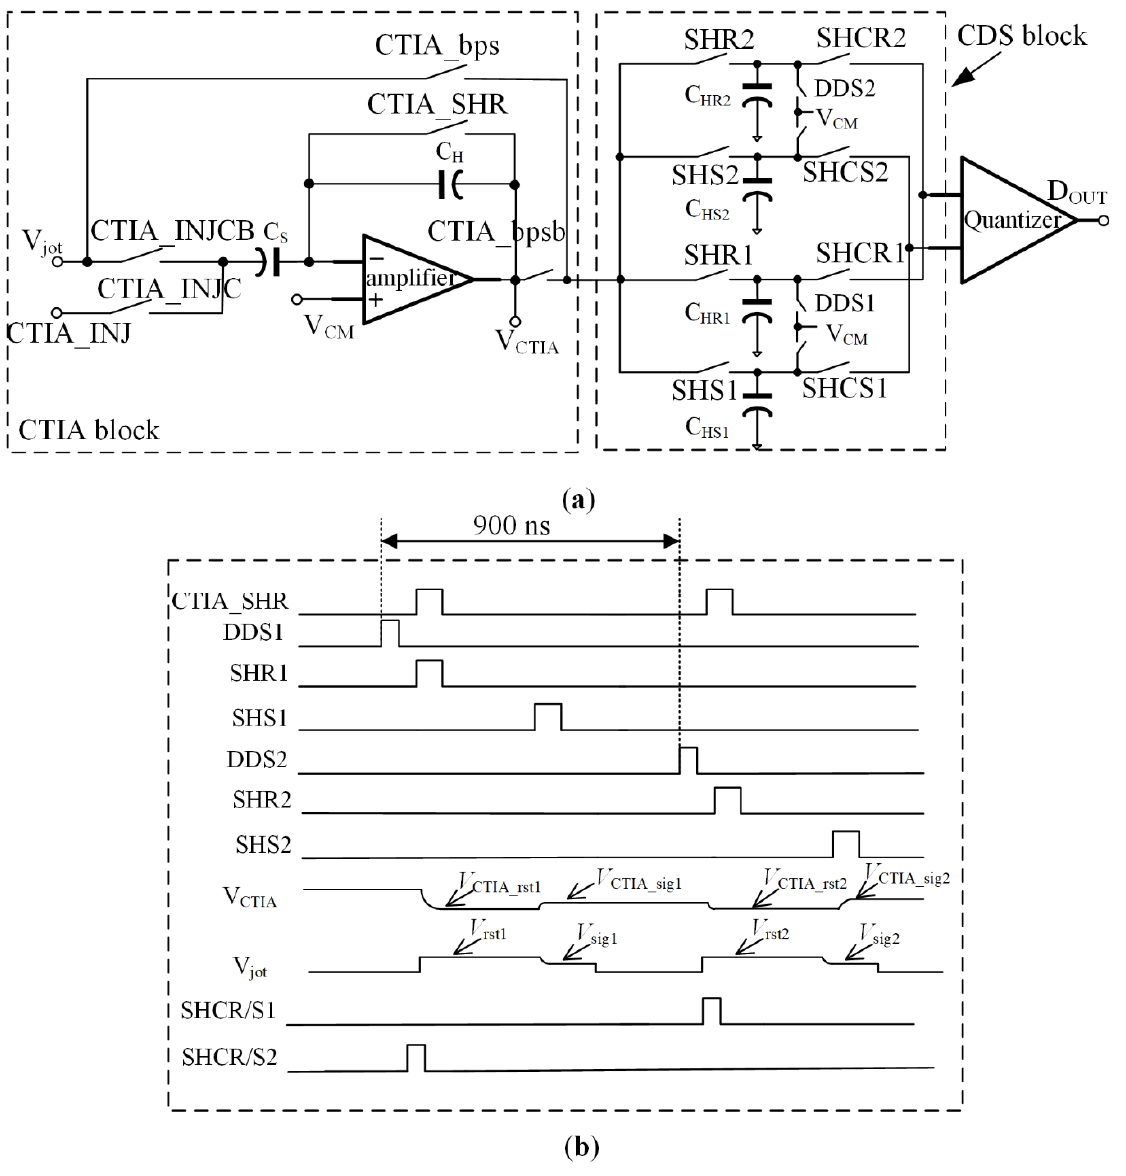
Figure 3. Readout chain: ( a ) diagram of the readout architecture from jot output to quantizer output and ( b ) timing diagram.